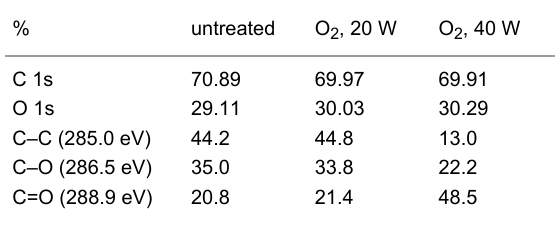
Table 2: Surface atomic composition (atom %) and concentration of the different chemical bonds (%) on the untreated and the O 2 -plasma- treated nanofibrous